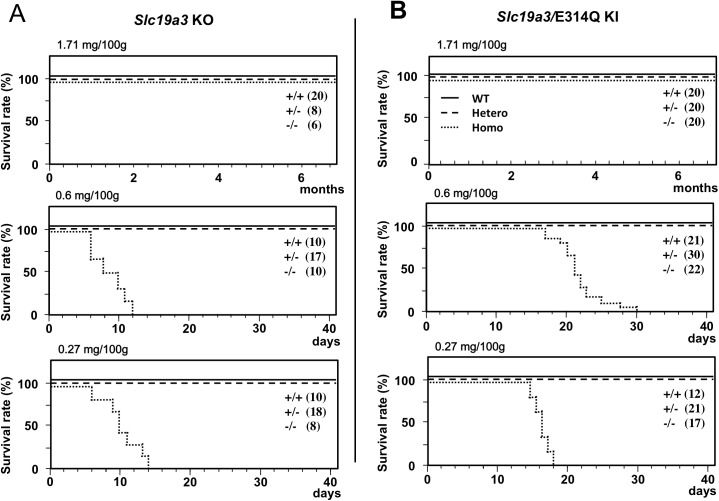
Survival rates of Slc19a3 KO and KI mice fed with a conventional (thiamine: 1.71 mg/100 g food) and thiamine-deficient (thiamine: 0.60 or 0.27 mg/100 g food) diet.A. Survival rates of Slc19a3 KO mice. B. Survival rates of Slc19a3 KI mice. Thick lines, wild type (+/+); broken lines, heterozygous (+/-); and dotted lines, homozygous mice (-/-).